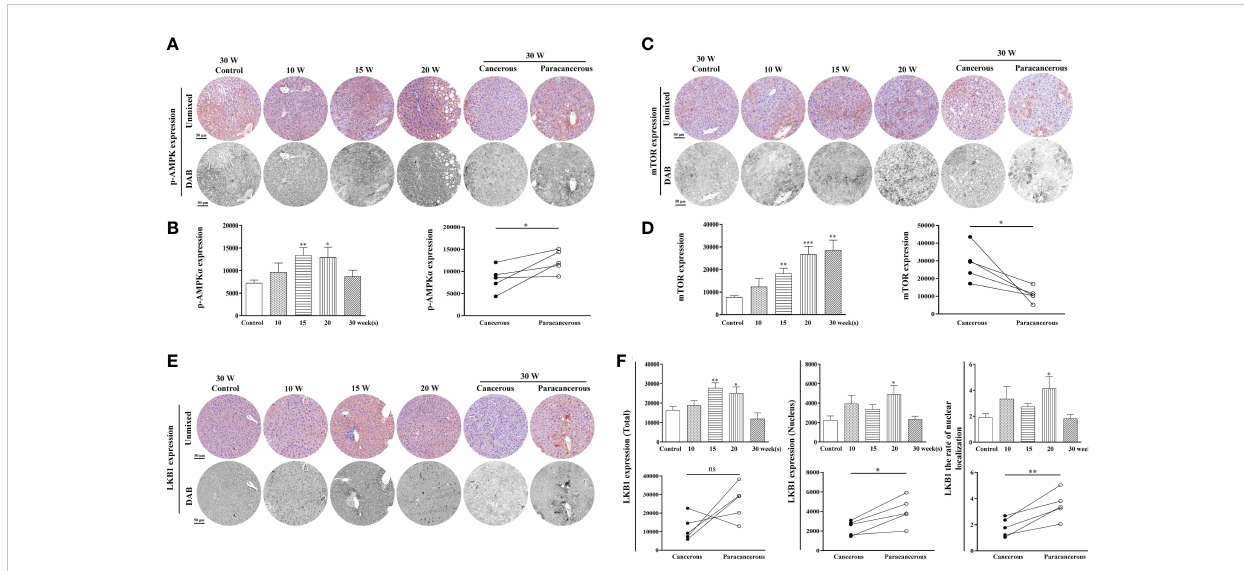
FIGURE 2 Immunohistochemical staining of p-AMPK, mTOR, and LKB1 proteins in mouse livers at different time points and their quantitative representative images. (A) Representative images of immunohistochemical staining of p-AMPK in mouse livers during liver carcinogenesis. (B) Quantitative multispectral image of the p-AMPK protein. (C) Representative images of immunohistochemical staining of mTOR in mouse livers during liver carcinogenesis. (D) Quantitative multispectral image of the mTOR protein. (E) Representative images of immunohistochemical staining of LKB1 in mouse livers during liver carcinogenesis. (F) Quantitative multispectral image of the LKB1 protein. The experimental data are expressed as the mean ± SEM. Compared to the control, * p < 0.05; ** p < 0.01; *** p < 0.001. Compared to paracancerous regions, * p < 0.05. Scale bar, 50 µm. ns, not